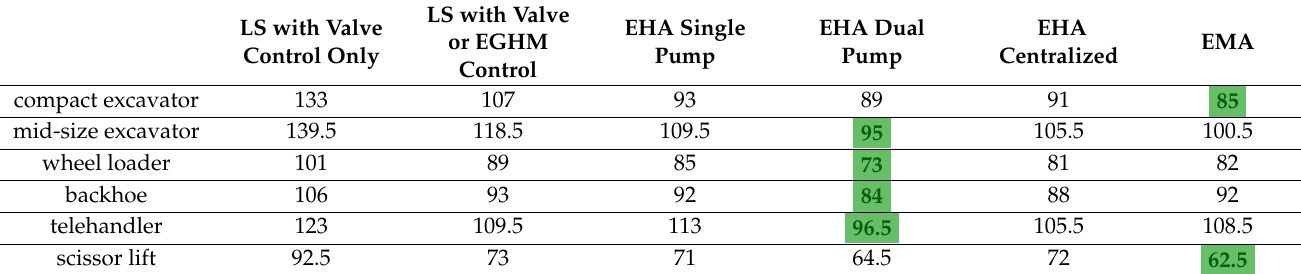
Table 4. Mismatch values for all 36 actuator-HDMM matches and weight matrix W = W 0 ⋅ W efficiency . The best values for each HDMM type have been marked